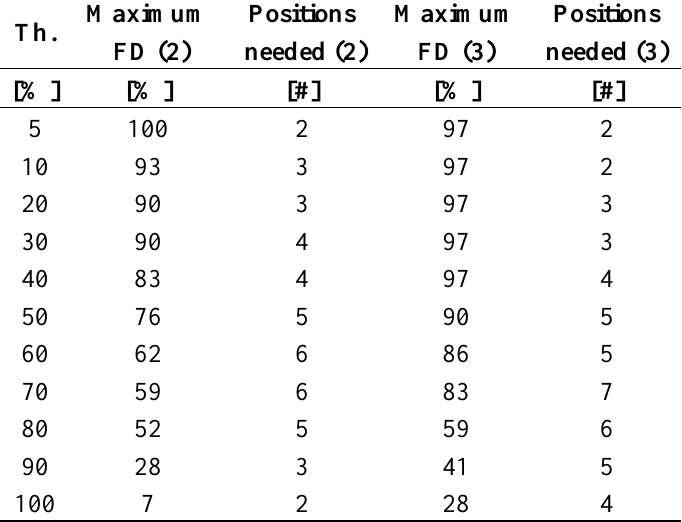
Table 4. Maximum FD and the number of positions needed to reach that FD for different FV threshold values (Th.). Values given for second session (2) and the third session (3). Maximum Positions Maximum Positions Th. FD (2) needed (2) FD (3) needed (3) [%] [%] [#] [%] [#]